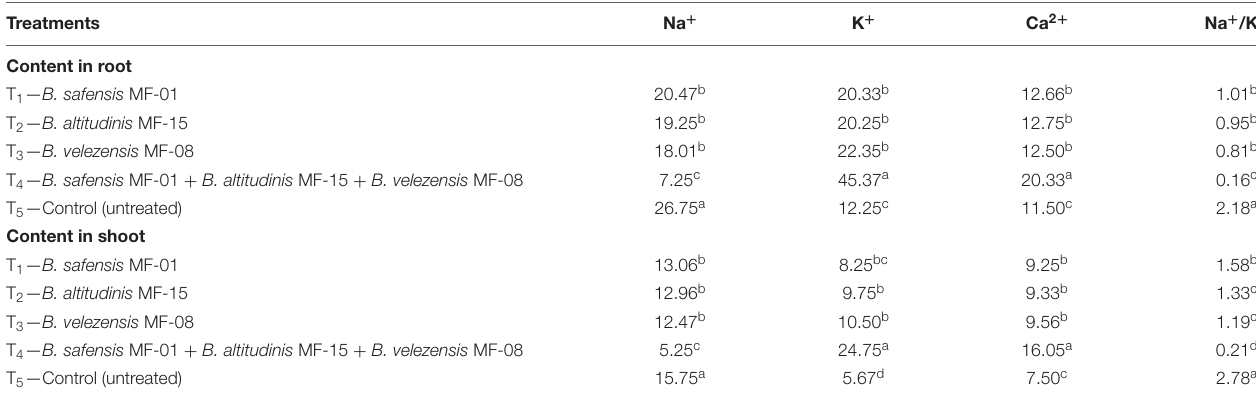
TABLE 9 | Effects of seed biopriming and microbial intervention on Na + , K + , and Ca 2 + uptake in maize grown in Kharif season under field conditions at harvest. Treatments Na + Content in root